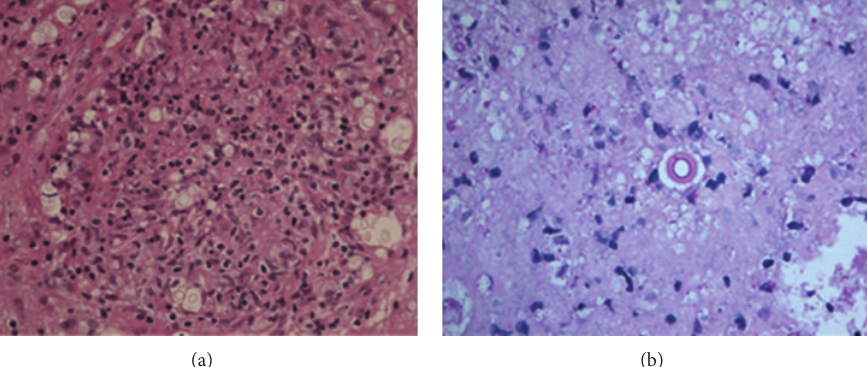
Figure 2: (a) Brain biopsy taken in December 2005, 4 months after initial presentation showing reactive gliosis and focally distended perivascular spaces containing Cryptococcus. (b) Brain biopsy taken in December 2006, 16 months after initial presentation showing encapsulated, budding yeast forms, scattered singly with some surrounding necrosis and moderate chronic inflammation. No granulomata were